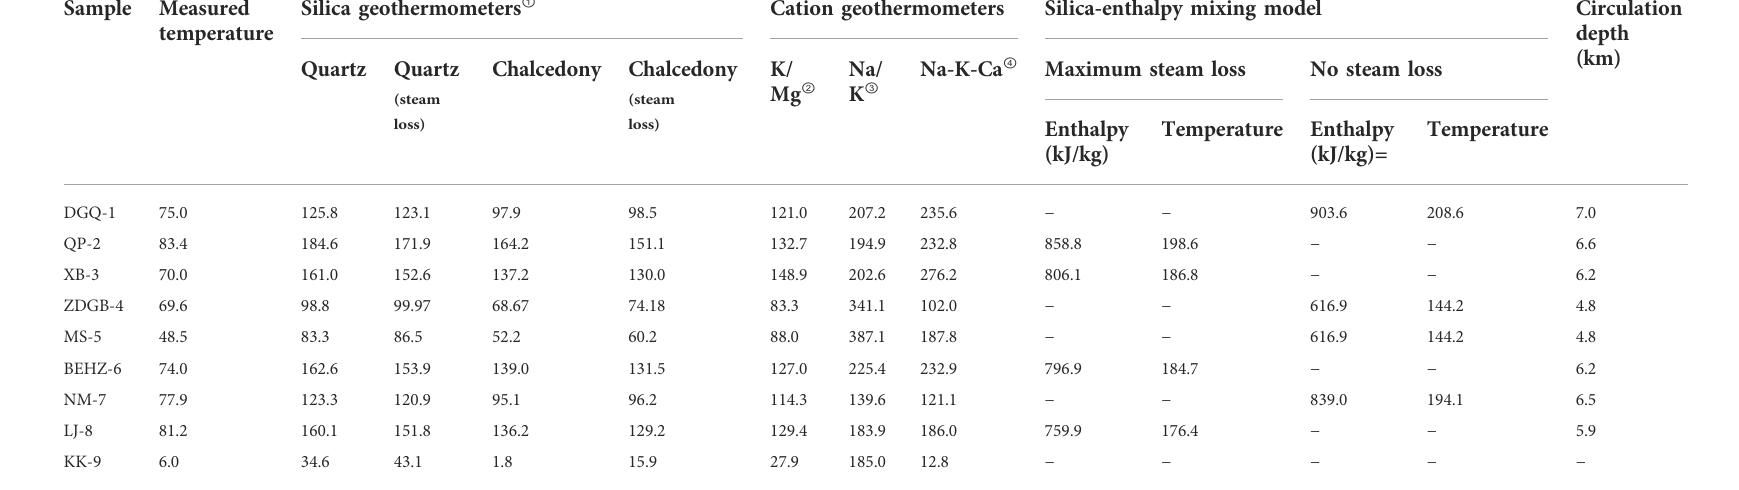
Note: Geothermometers are from ① Quartz geothermometer: If no loss of steam, t ( ℃ ) (cid:1) 1522/5 . 19 − logSiO 2 − 273 . 15; If maximum steam loss, t ( ℃ ) (cid:1) 1522 5 . 75 − logSiO t ( ℃ ) (cid:1) 1032/4 . 69 − logSiO 2 − 273 . 15;If maximumsteamloss,t ( ℃ ) (cid:1) 1264/5 . 31 − logSiO 2 − 273 . 15 (Fournier,1977); ② T K / Mg (cid:1) 4410/13 . 95 − log ( K 2 / Mg )− 273 . 15(Giggenbach,1988); ③ T Na / K (cid:1) 1052/1 + e ( 1 . 714×log ( Na / K )+ 0 . 252 ) + 76(Can,2002);